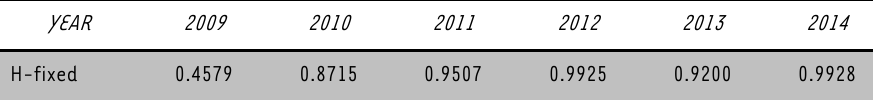
TABLE 7: Evolution of the Panzar-Rosse H-statistic